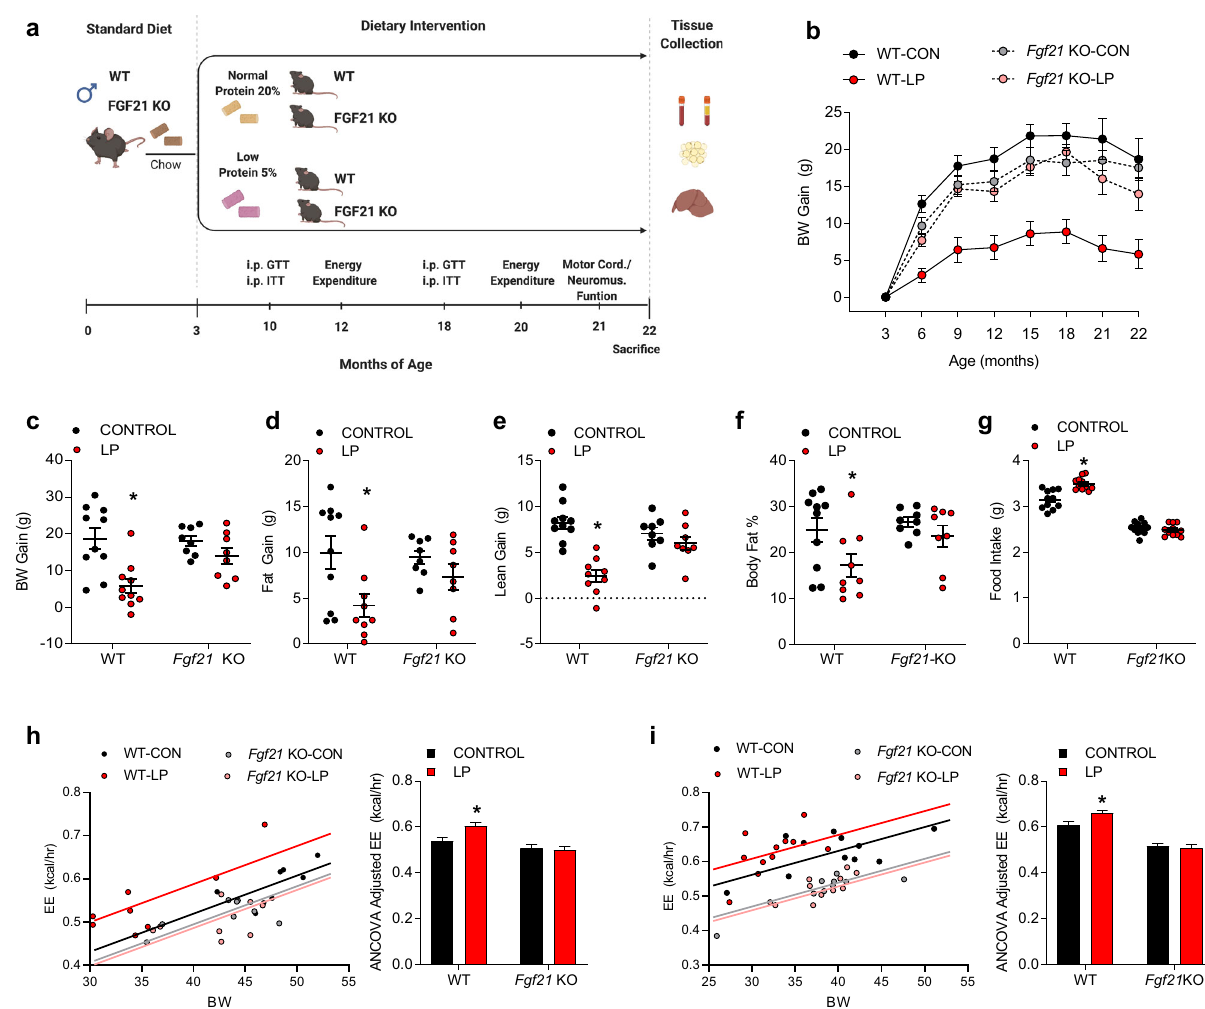
Fig. 2 FGF21 mediates low protein-induced changes in BW gain, food intake, and body composition in aged mice. a Schematic representation of the metabolic aging study. Wildtype and Fgf21 -KO mice were placed on control or LP diet at 3 months of age (12 mice/group), with various metabolic endpoints assess throughout the study as indicated, and tissue collection at 22 months of age. b Body weight gain over time following initiation of experimental diets, n = 12 mice/group, group*time p = 0.001. c Final body weight gain at 22 months of age ( n = 8 – 12 mice/group at sacri fi ce; geno*diet p = 0.0004). d Final body fat gain at 22 months of age as measured by NMR ( n = 8 – 12 mice/group at sacri fi ce; geno*diet p = 0.03). e Final body lean gain at 22 months of age as measured by NMR ( n = 8 – 12 mice/group at sacri fi ce; geno*diet p = 0.0001). f Percent body fat at 22 months of age as measured by NMR ( n = 8 – 12 mice/group at sacri fi ce; geno*diet p = 0.03). g Average daily food intake throughout the study ( n = 8 – 12 mice/group at sacri fi ce; geno*diet p = 0.0001). h Energy expenditure (ANCOVA adjusted for BW) as measured at 12 months of age ( n = 8 – 12 mice/group at sacri fi ce; geno*diet p = 0.04). i Energy expenditure (ANCOVA adjusted for BW) as measured at 20 months of age ( n = 8 – 12 mice/group at sacri fi ce; geno*diet p = 0.04). Statistical analyses were conducted using two-way ANOVA or ANCOVA. All values are mean ± SEM, with signi fi cant posthoc comparison within